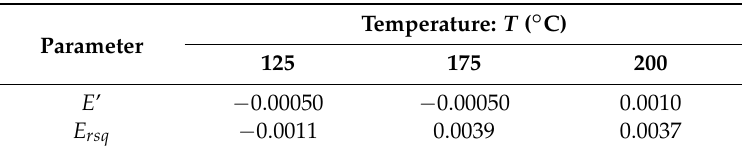
Table 7. Mean maximum relative errors and sum of squared errors relative to 25 ◦